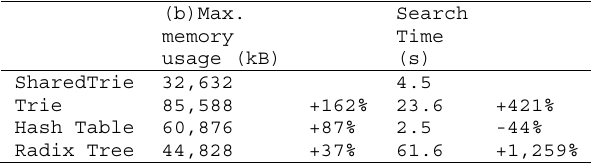
Table 2. Results of the